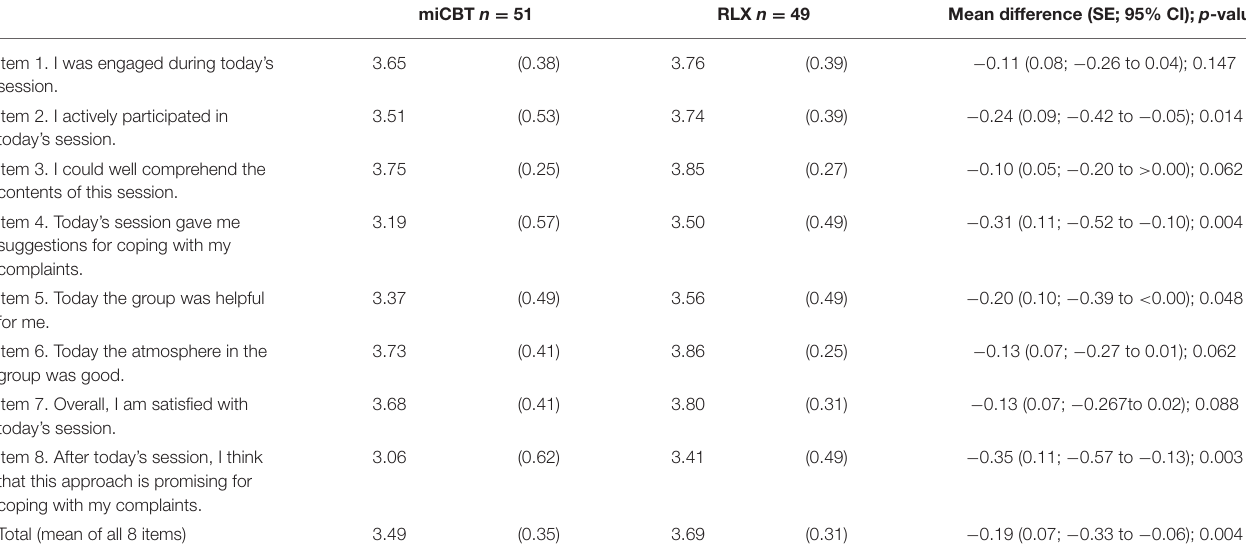
TABLE 3 | Session evaluation by the